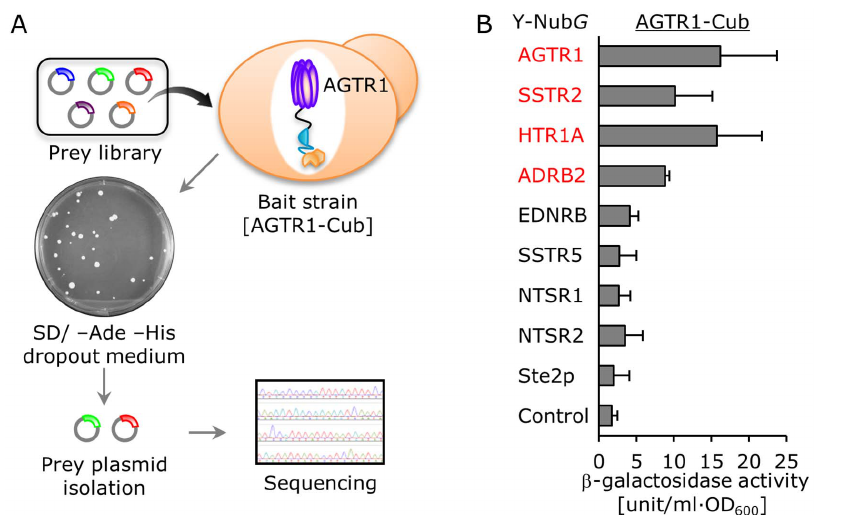
Figure 6. Screening of candidate heterodimer partners of AT 1 angiotensin receptor (AGTR1). (A) Workflow of a yeast two-hybrid screen. Prey library was transformed into the NMY63 yeast strains harboring AGTR1 bait vector, and the selection with growth reporter genes was performed. Following isolation of prey plasmids from each colony, the obtained GPCR clones were determined by sequencing analysis. (B) Quantitative b - galactosidase assays for homo- and hetero-dimerization of AGTR1 in NMY63 strain. NMY63 yeast strain was transformed with GPCR-Nub G indicated at the left and AGTR1-Cub-LexA-VP16. The control prey plasmid was pPR3-C mock vector. Error bars represent the standard deviations ( n= 3).